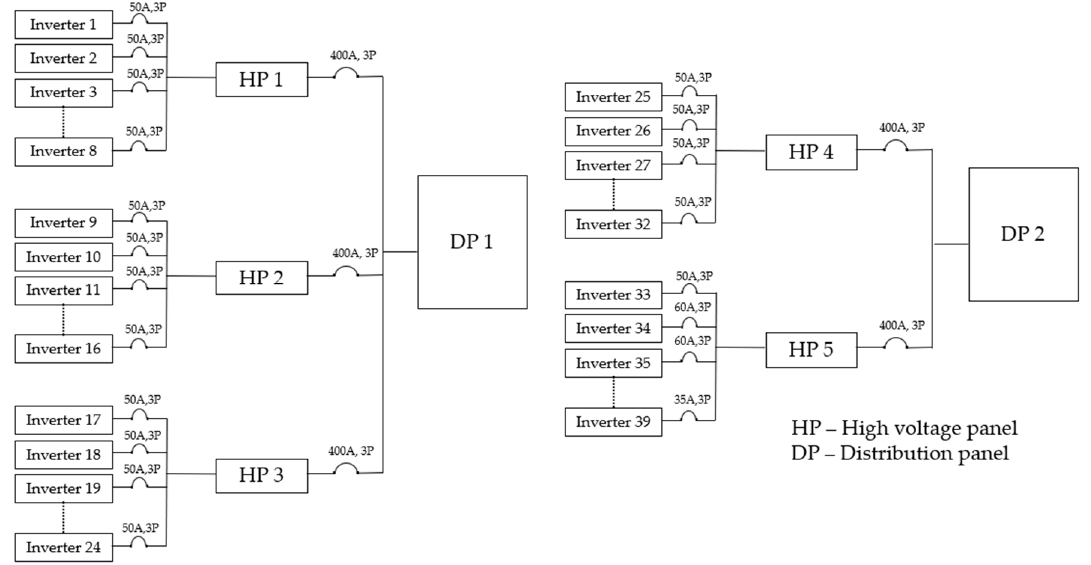
Figure 3. Line diagram of high voltage panels (HP) and distribution panels (DP).